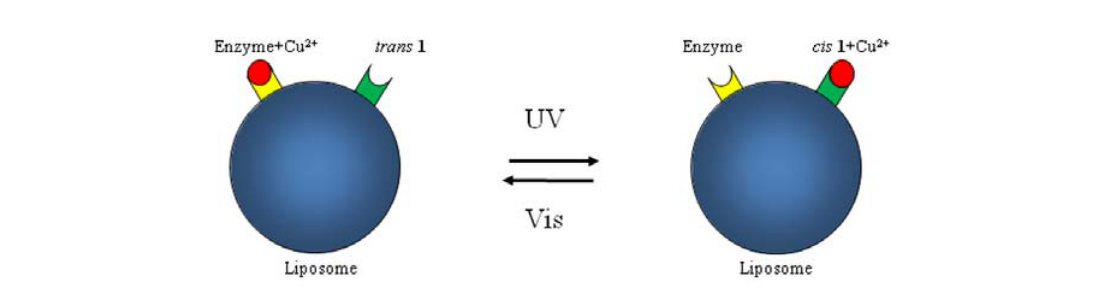
Figure 40. Photo-control of enzymatic